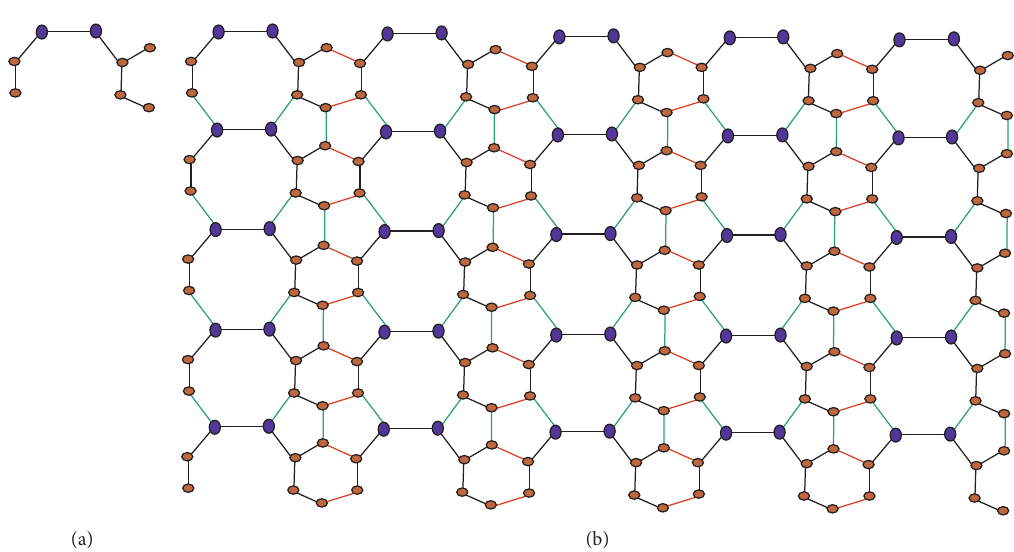
Figure 6: The unit cell and SiC